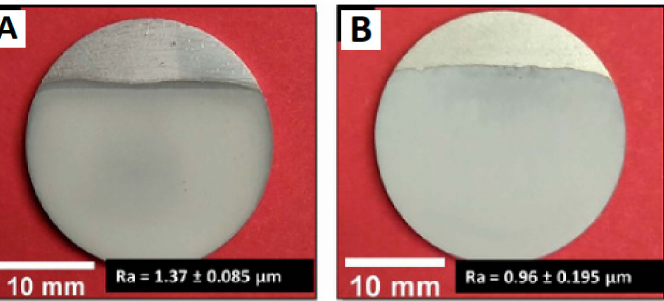
Figure 22. Optical images and roughness values of the geopolymer (obtained by alkaline activation) coating ( A ) and of the geopolymer (obtained by acidic activation) coating ( B )